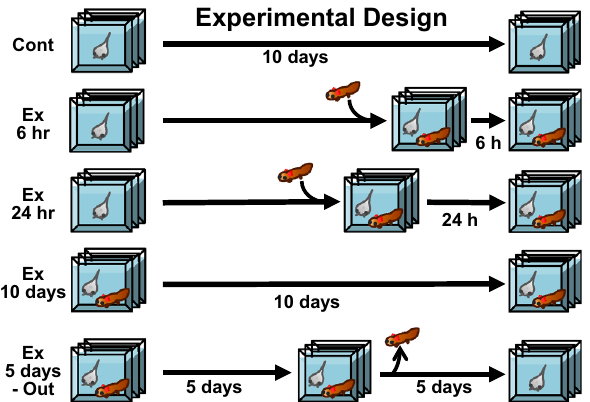
Figure 1. Experimental design for inducing predation in Xenopus tadpoles. Xenopus tadpoles were assigned to 5 different treatment groups. The control group (Cont) was not exposed to the salamander predator during the experiment (10 days). Tadpoles in the 6 h and 24 h groups were exposed to a salamander larva for 6 or 24 h before sampling, respectively. The 10-day group was exposed to a salamander larva for 10 full days, while the 5-days out group was exposed to a salamander larva for 5 days, to induce the predation threat, then the salamander was removed, and the tadpoles were kept for a further 5 days without the predation